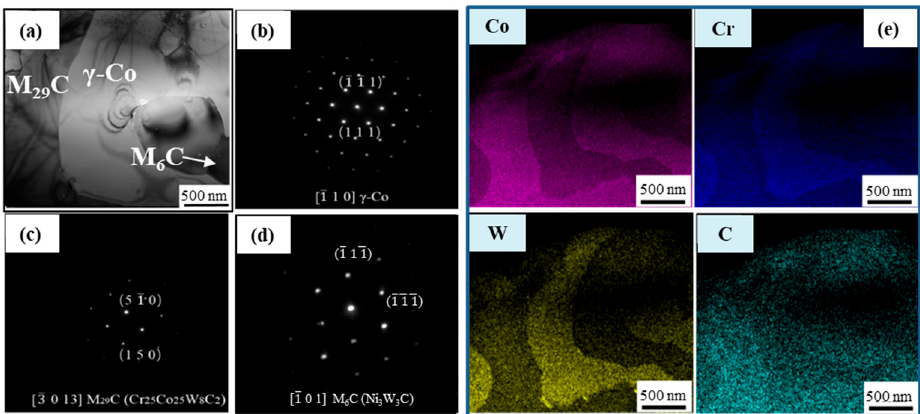
Figure 7. (a) TEM bright-field image of the Co–Cr–W alloy; ( b – d ) Selected area electron diffraction (SAED) patterns of γ -Co ( b ), M 29 C ( c ), and M 6 C ( d ); ( e ) and EDS maps performed on a micro-area.